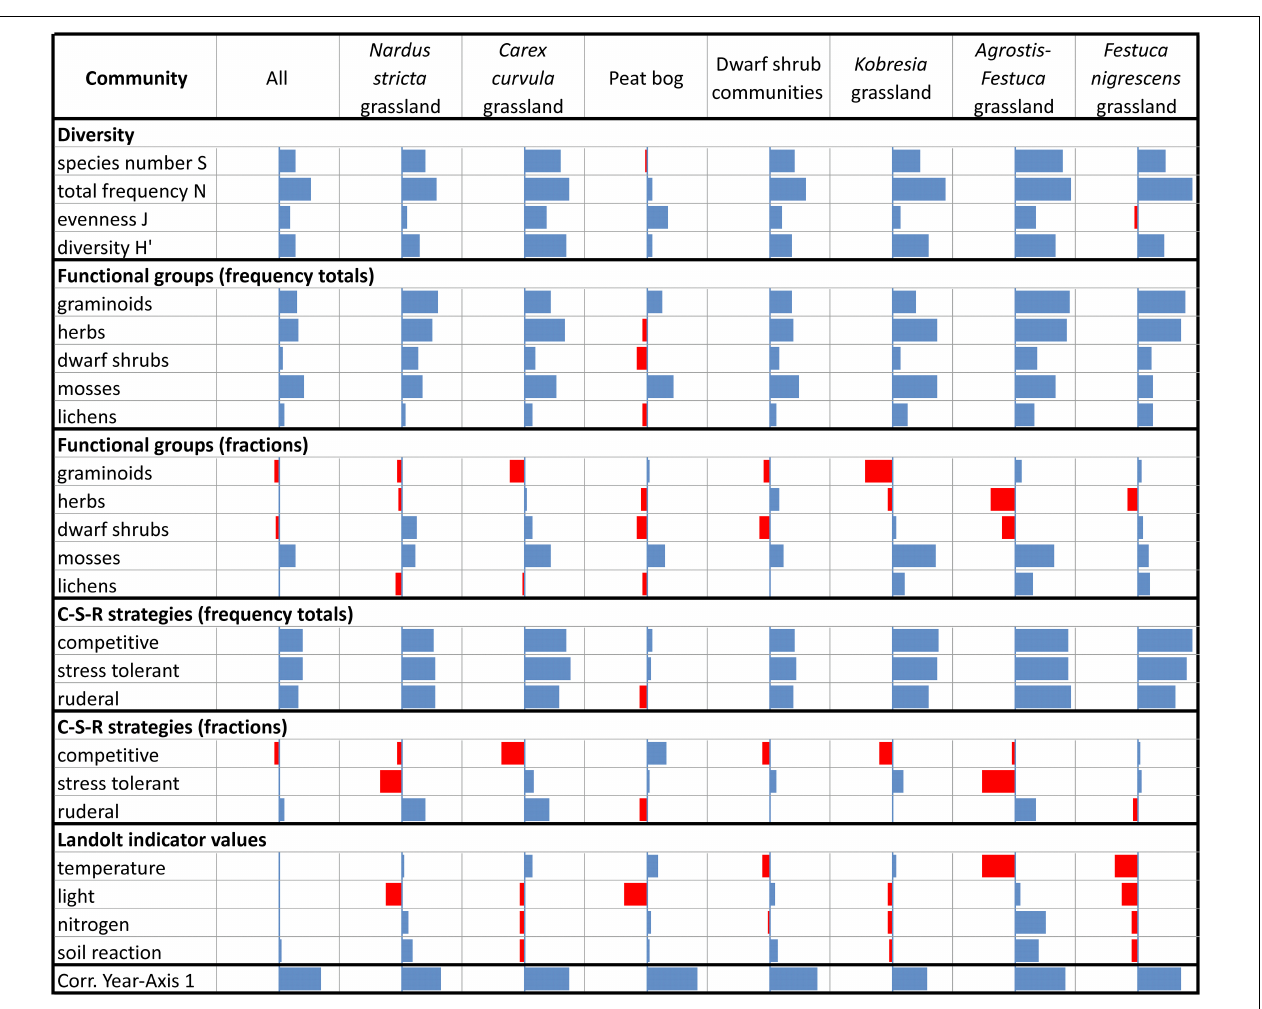
FIGURE 1 | Strength of time trend of community parameters (grazed sites): loadings on axis 1 (correlations) from pRDA representing the linear increase or decrease over time (range of bars –1 to +1). Bottom line shows correlation of explanatory variable Yr with pRDA axis 1. Results shown for the seven communities and for all communities